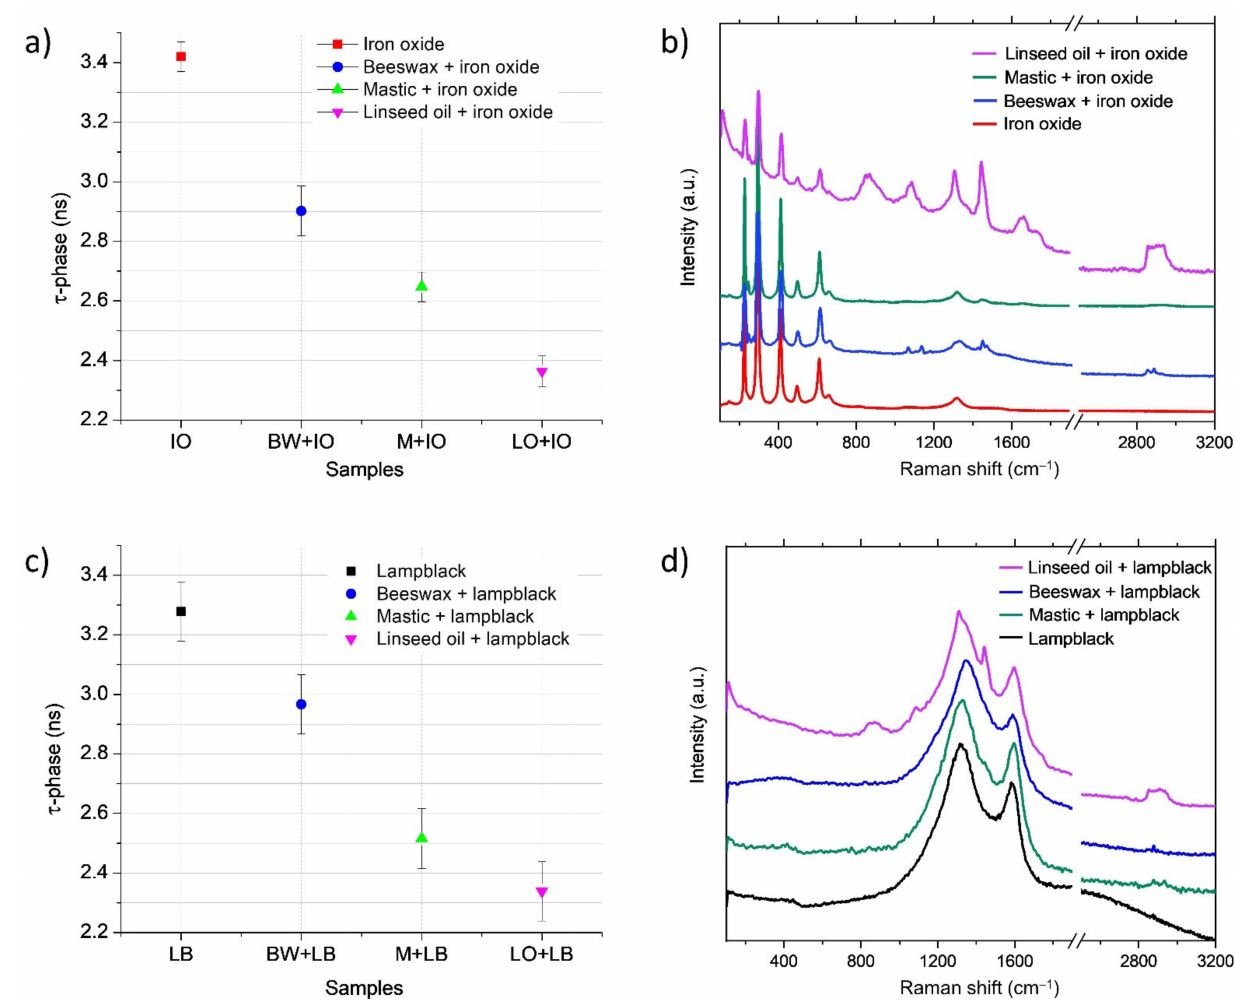
Figure 4. FL ( a , c ) and Raman ( b , d ) results for pigmented mixtures of LO, BW, and